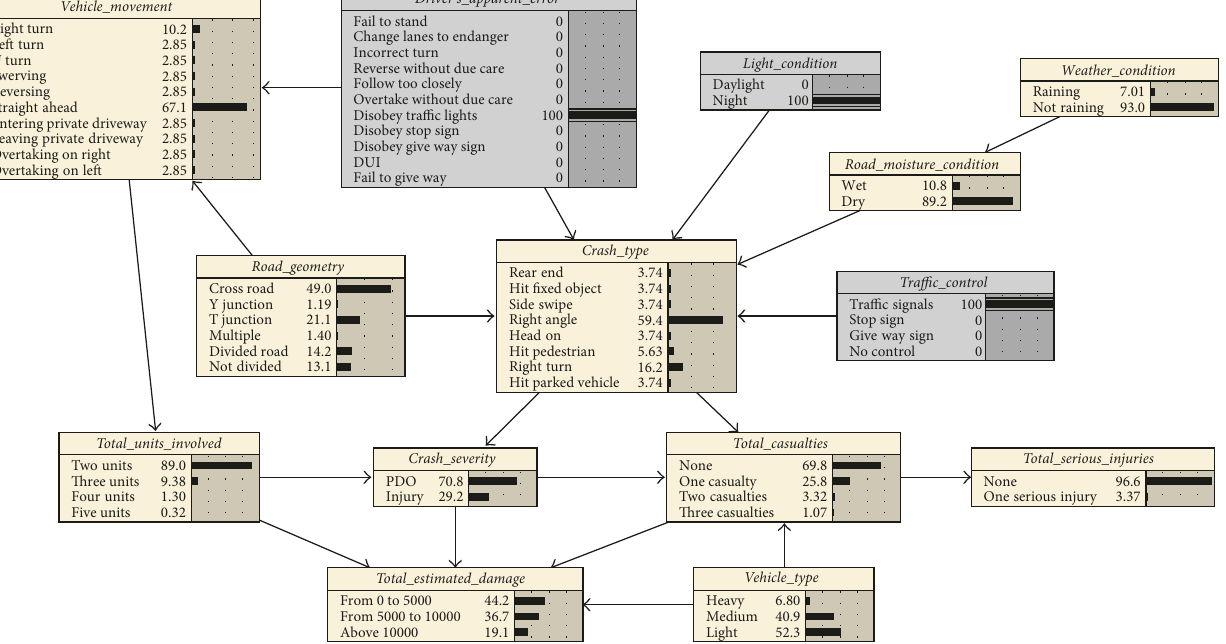
Figure 9: Road accident prediction when the evidence variables are “traffic signals,” “disobey traffic lights,” and “night.”